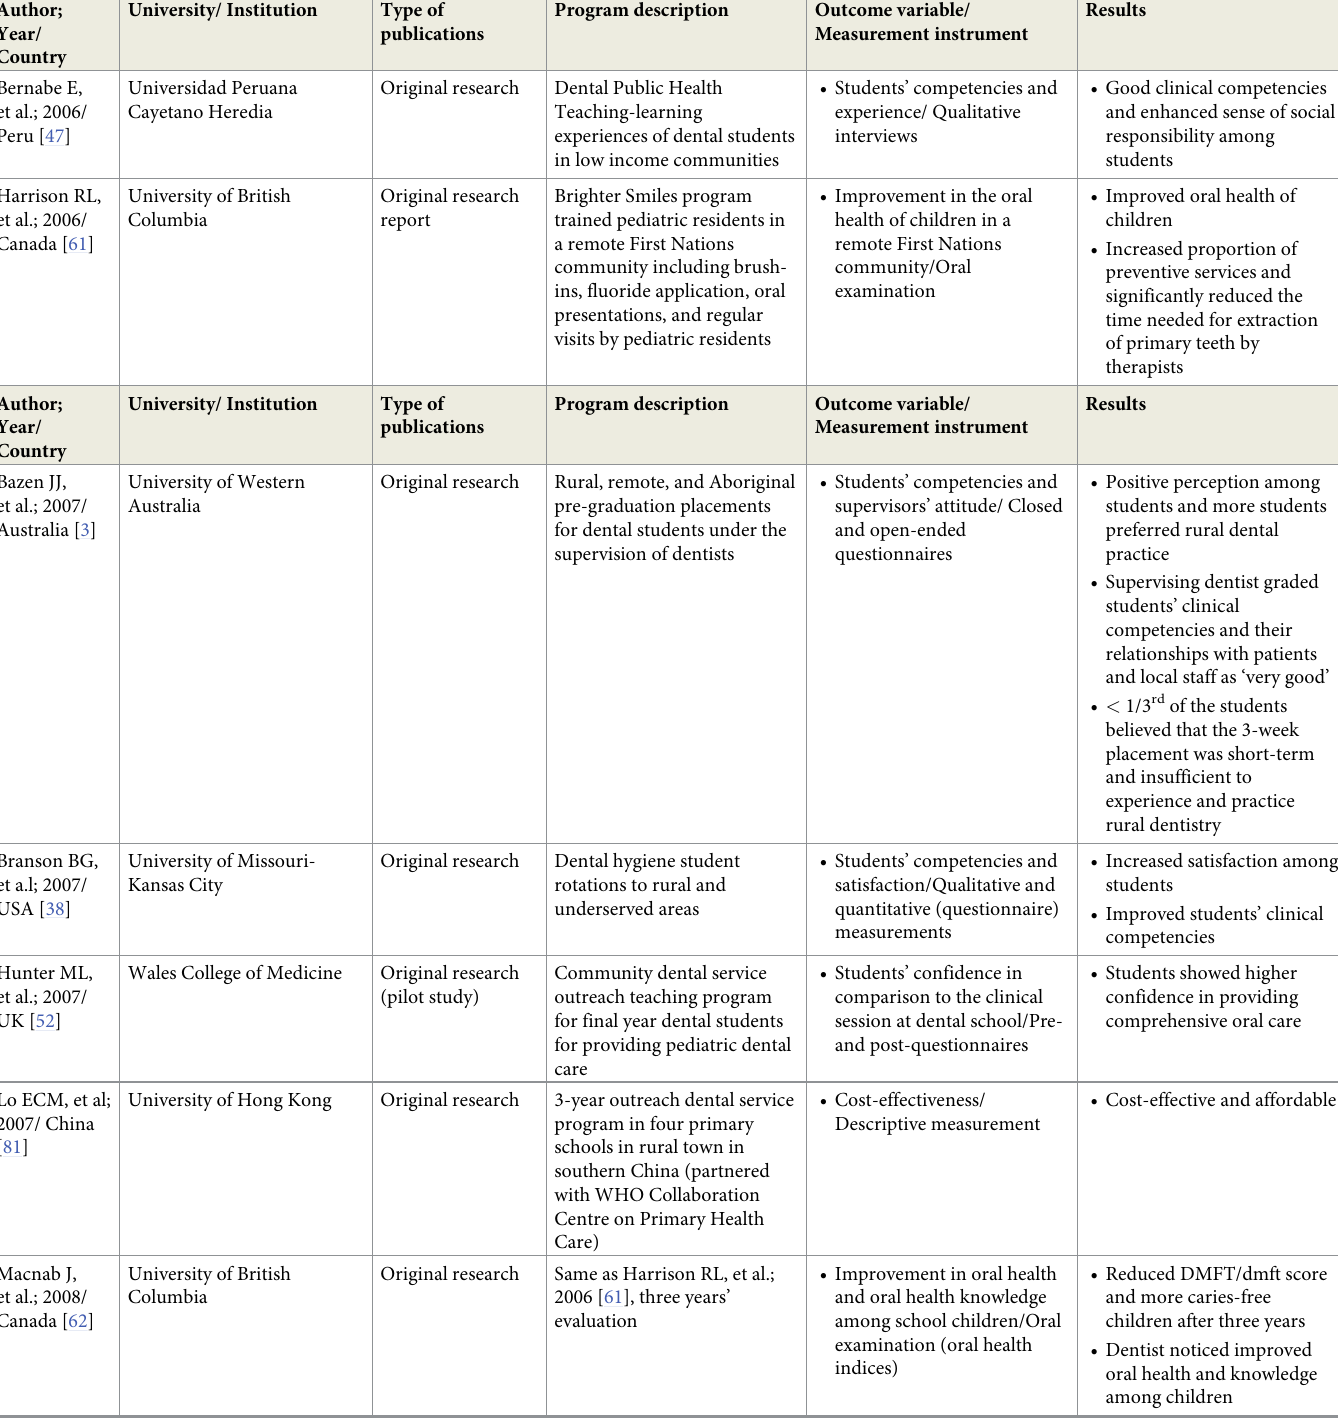
Table 4. Summary of published research articles identified in the scoping review